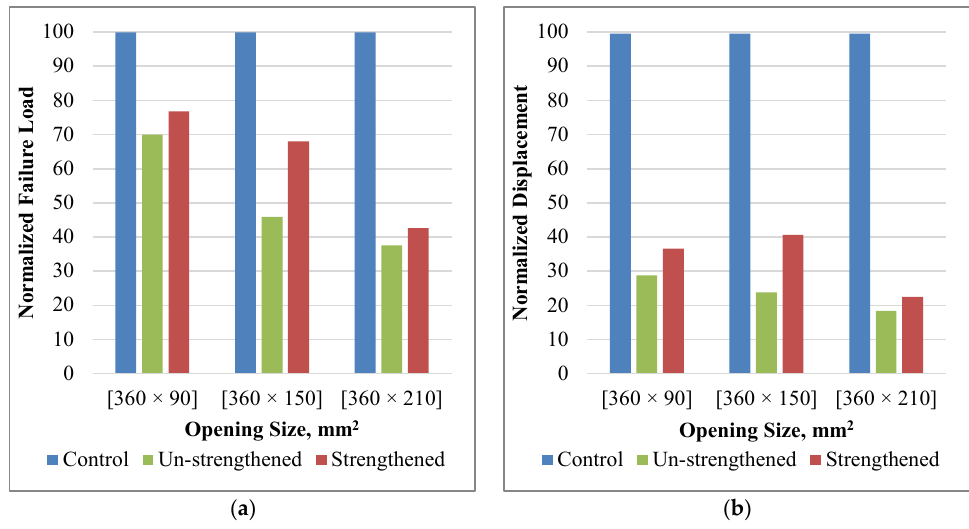
Figure 9. Effect of Strengthening and Shear Zone Opening Size . ( a ) failure load; ( b ) failure displace- ment.